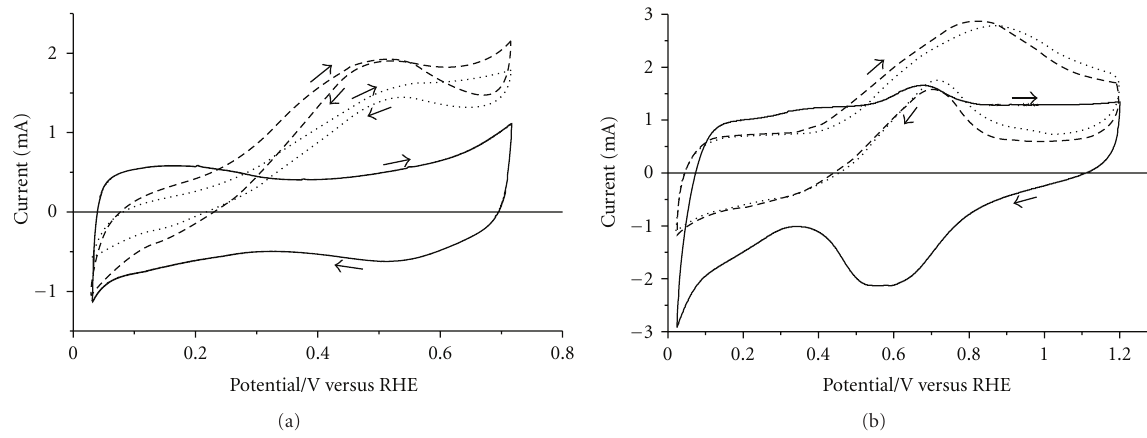
Figure 6: Cyclic voltammetry of ethanol solutions containing a mixture of ETBE and Bitrex at a PtSn catalyst in 0.5M H 2 SO 4 (a) and at a PdCoFe catalyst in 0.1M KOH (b). Base electrolyte (line), 1M ethanol (dashed), and 1 M ethanol + 0.24 wt.-% ETBE /0.5 mgL − 1 Bitrex (dotted). Scan rate 50mVs − 1 .